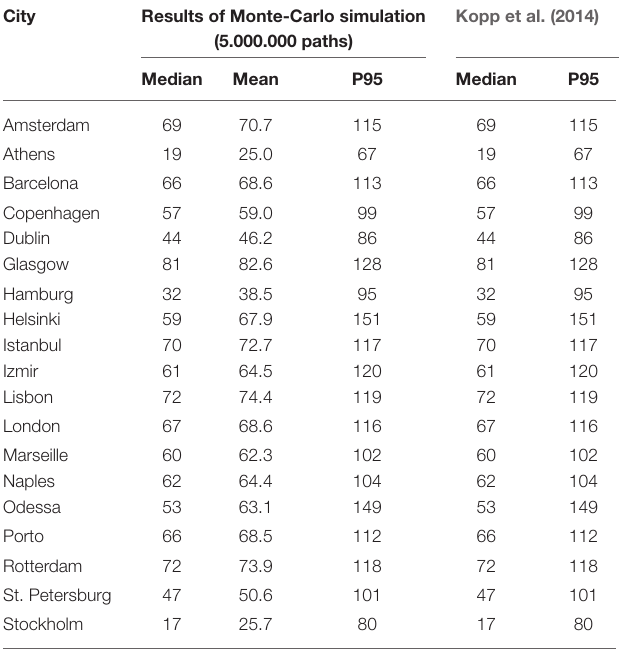
TABLE 3 | Theoretical and simulated values of sea-level rise in 2100 (cm). City Results of Monte-Carlo simulation